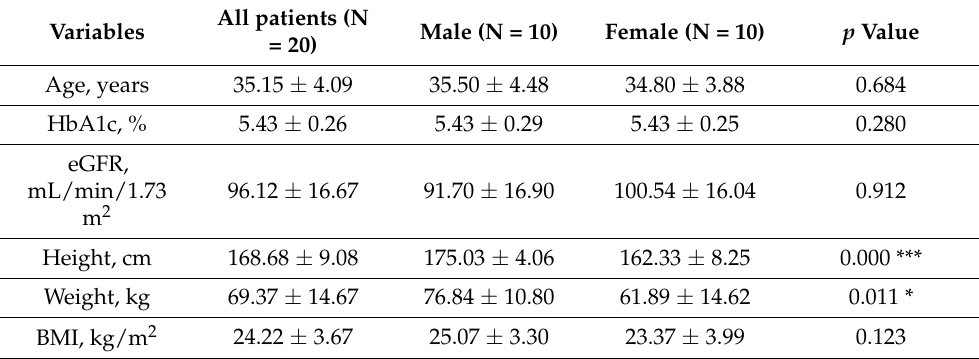
Table 1. Baseline characteristics of the healthy participants, stratified by sex ( n = 20). Variables